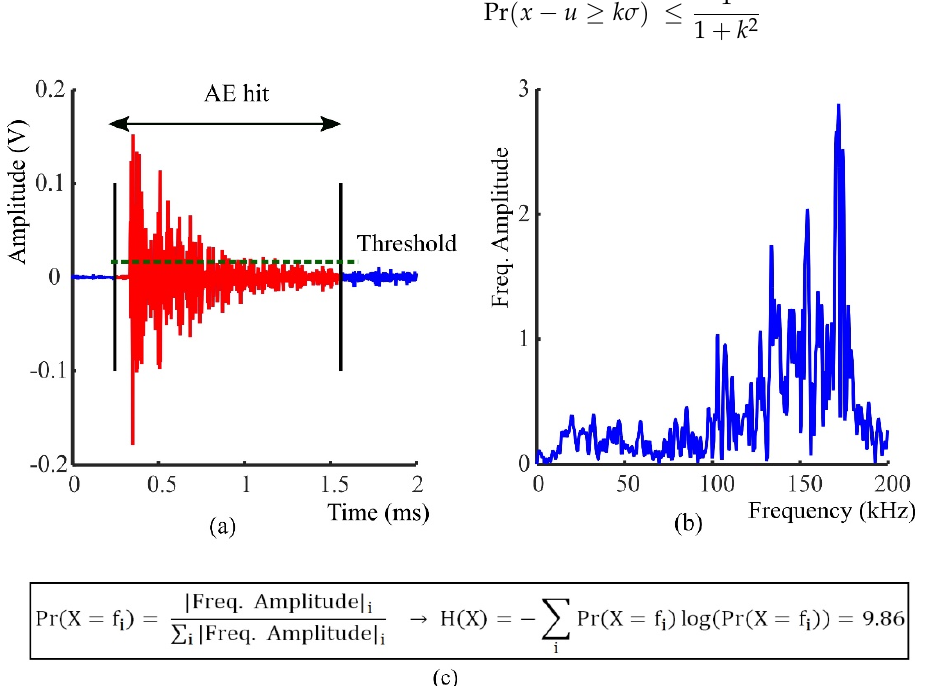
Figure 5. AE entropy calculation ( a ) Detected AE hit using RMS algorithm [8] ( b ) Frequency spectrum of AE hit ( c ) Applying the Shannon entropy formula to the normalized spectrum. In the example shown the entropy is 9.86.